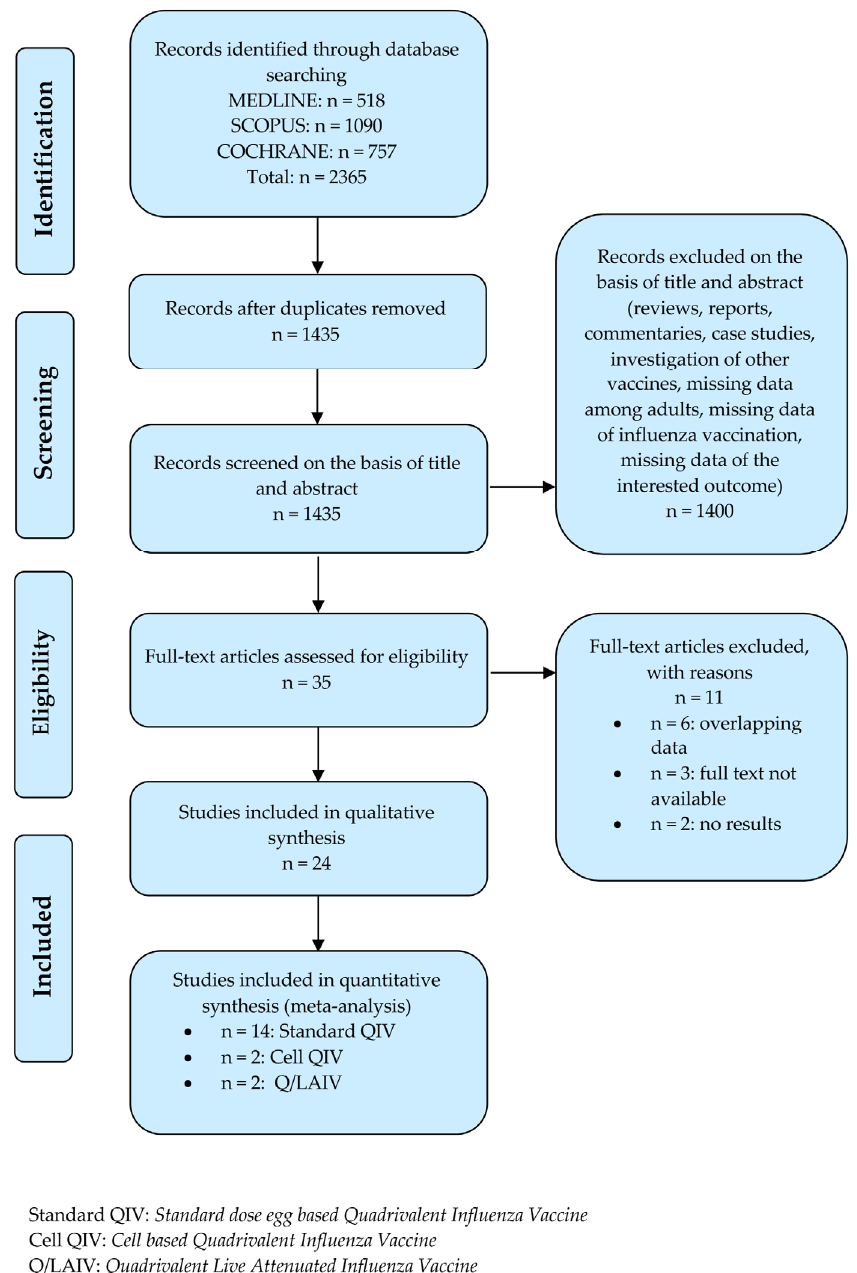
Figure 1. Flow diagram of the systematic literature search.